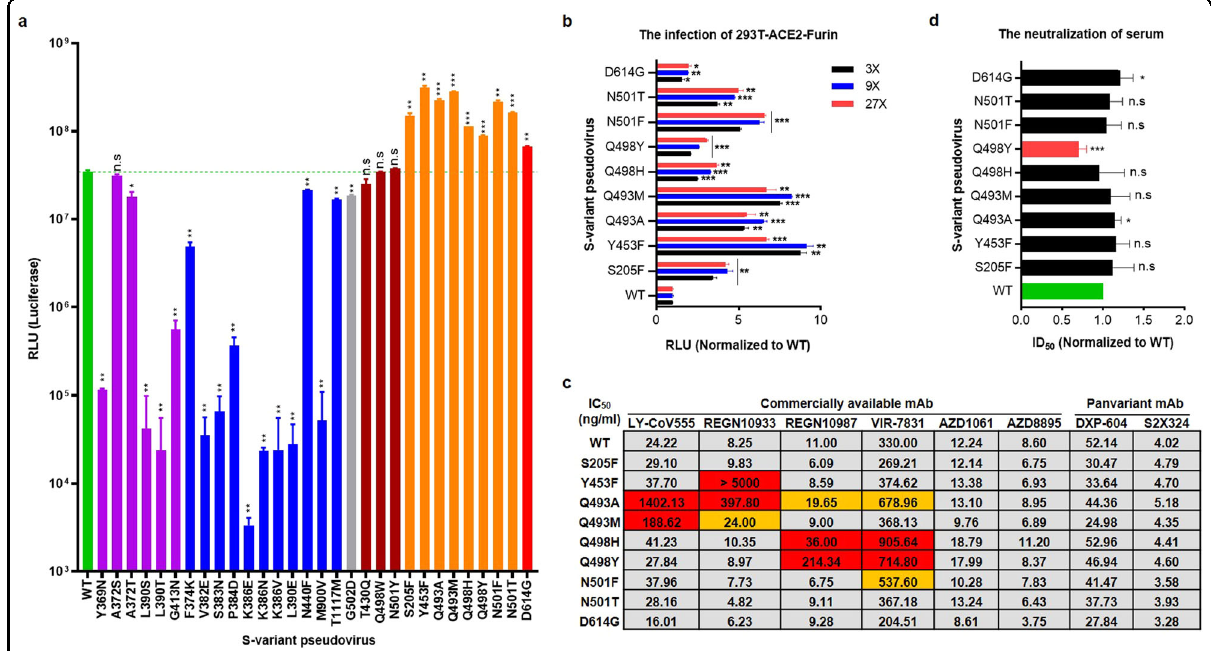
Fig. 5 Identi fi cation of high-risk mutations that elevated the viral infectivity and immune evasion. a The RLU (luciferase) signal reading out from the tested S variant pseudoviruses. The green, gray, and red columns represent the WT, G502D, and D614G reference strain, respectively. The purple columns represent the N -glycan-related S variants (Y369N, A372S/T, L390S/T, G413N). The blue columns indicate the possible furin cleavage- related S variants (F374K, V382E, S383N, P384D, K386E, K386N, K386V, L390E, N440F, M900V, and T1117M). The brown columns represent the S variants (T430Q, Q498W, and N501Y) with comparable infectivity to WT. The orange columns indicate the S variants with improved infectivity (S205F, Y453F, Q493A, Q493M, Q498H, Q498Y, N501F, and N501T). b The infectivity of S variants pseudoviruses normalized to the WT (3×, 9×, and 27× dilution), which were measured in the context of 293T-ACE2-Furin cell line. D614G was set as positive control. c The IC 50 (ng/mL) of high-risk S variant pseudoviruses with diverse mAbs. Each mAb was set 8 gradient dilution with two duplicates of each dilution. The red and yellow highlighted numbers show the signi fi cant and mild evasion to mAb, respectively. d The ID 50 values of high-risk S variant pseudoviruses with serum antibodies. The tested sera were obtained from four female guinea